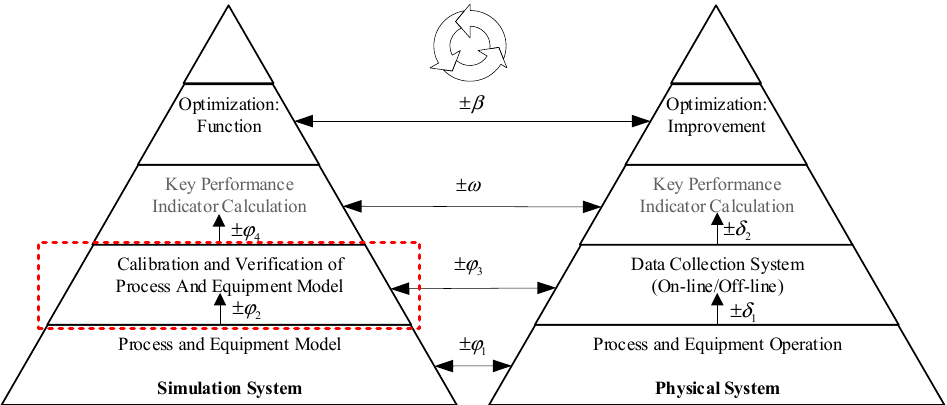
Figure 1. Error propagation model for the implementation of the optimization functionality in crushing plants [4].